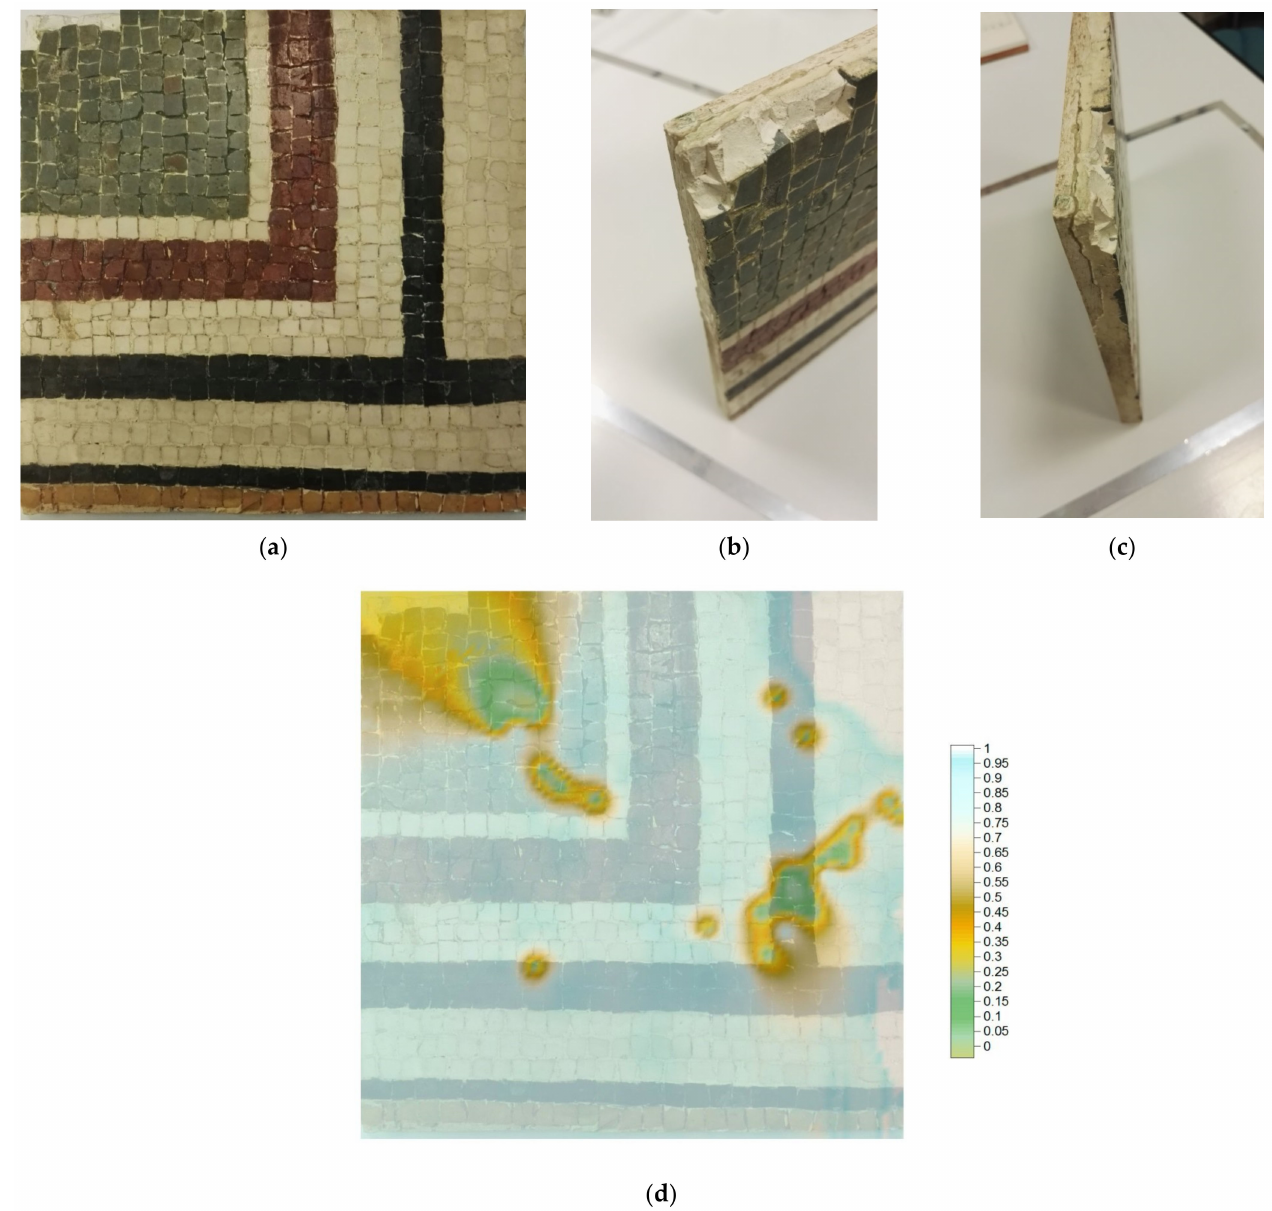
Figure 10. In ( a ) Roman floor mosaic (ca. 20 × 20 cm). In ( b , c ) there is a clear detachment from the adhesion surface. In ( d ) the analysis carried out with the device described in this paper, obtained with about 200 measurement points and superimposed on the photo of the handwork for a better understanding of the position of the